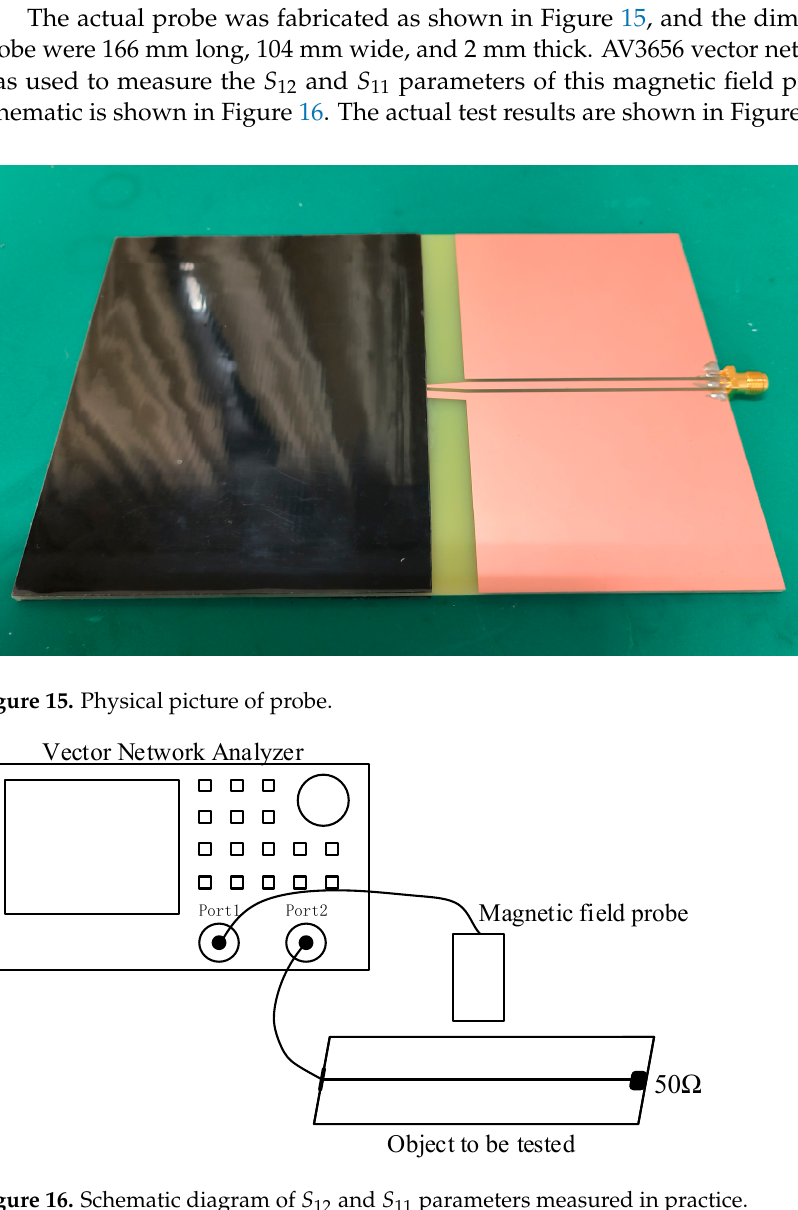
Figure 17. Comparison of test simulations of the 11 S parameters of the magnetic field probe. Figure 18. Comparison of test simulations of the 12 S parameters of the magnetic field probe.